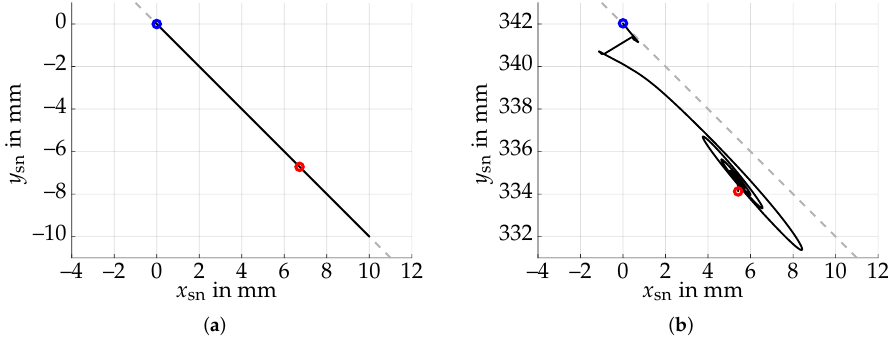
Figure 6. Trajectory of the surface normal vector when applying the optimized inputs for spheres with different initial angles. The desired direction corresponds to a − 45°-line (dashed). ( a ) The sphere is initialized with zero angles (blue circle) and the surface normal trajectory lies on the line of the desired direction. The final deflection corresponds to 0.54° (red circle). ( b ) Applying the same inputs for an initial rotation of α = − 20° (blue circle) leads to an additional motion in the direction perpendicular to the − 45°-line. The final state is marked by a red circle.